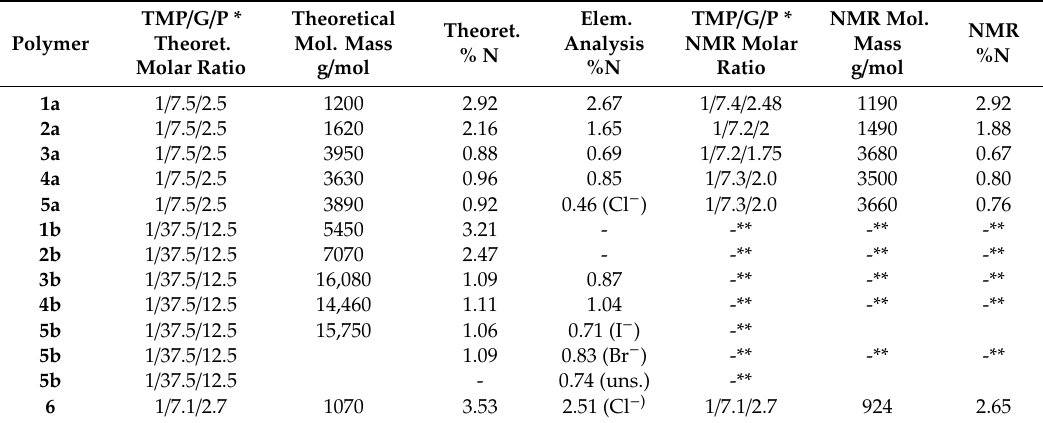
Table 6. Characterization of obtained polymers.